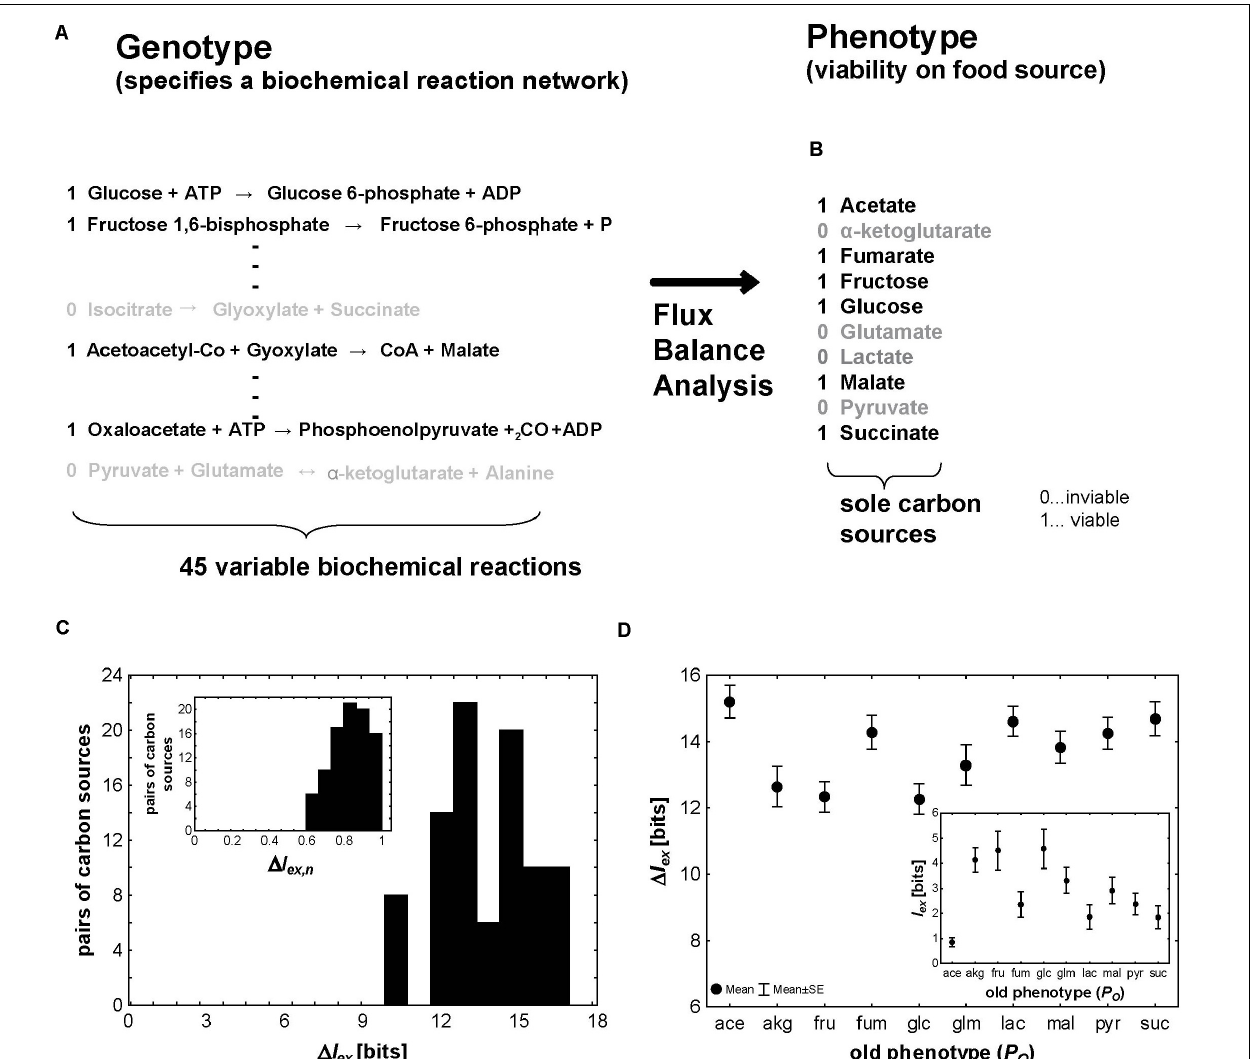
FIGURE 3 | Metabolic exaptations. (A) The genotype encoding a network of metabolic reactions can be represented through the presence (black type, “1”) or absence (gray type, “0”) of individual metabolic reactions, which are represented in this hypothetical example through their stoichiometric equations. In this analysis I consider 45 reactions from central carbon metabolism whose presence can vary and still allow viability. (B) The environments I consider here are chemically minimal environments (Hosseini et al., 2015) that differ only in one of the 10 carbon sources shown here. A carbon source is shown as supporting viability (black type, “1”) if a metabolism can synthesize each of 12 different biomass precursors ( Supplementary Figure S1 ) when this carbon source is the only carbon source. (C) Distribution of (cid:49) I ex (in bits) and the normalized (cid:49) I ex , n (inset) for the 90 pairs of carbon sources that can be formed by the 10 carbon sources I consider here. (D) Mean (circles) and standard error of the mean (whiskers) for (cid:49) I ex (in bits) and I ex (inset) for the nine novel phenotypes that can be formed from each of the 10 old phenotypes shown on the horizontal